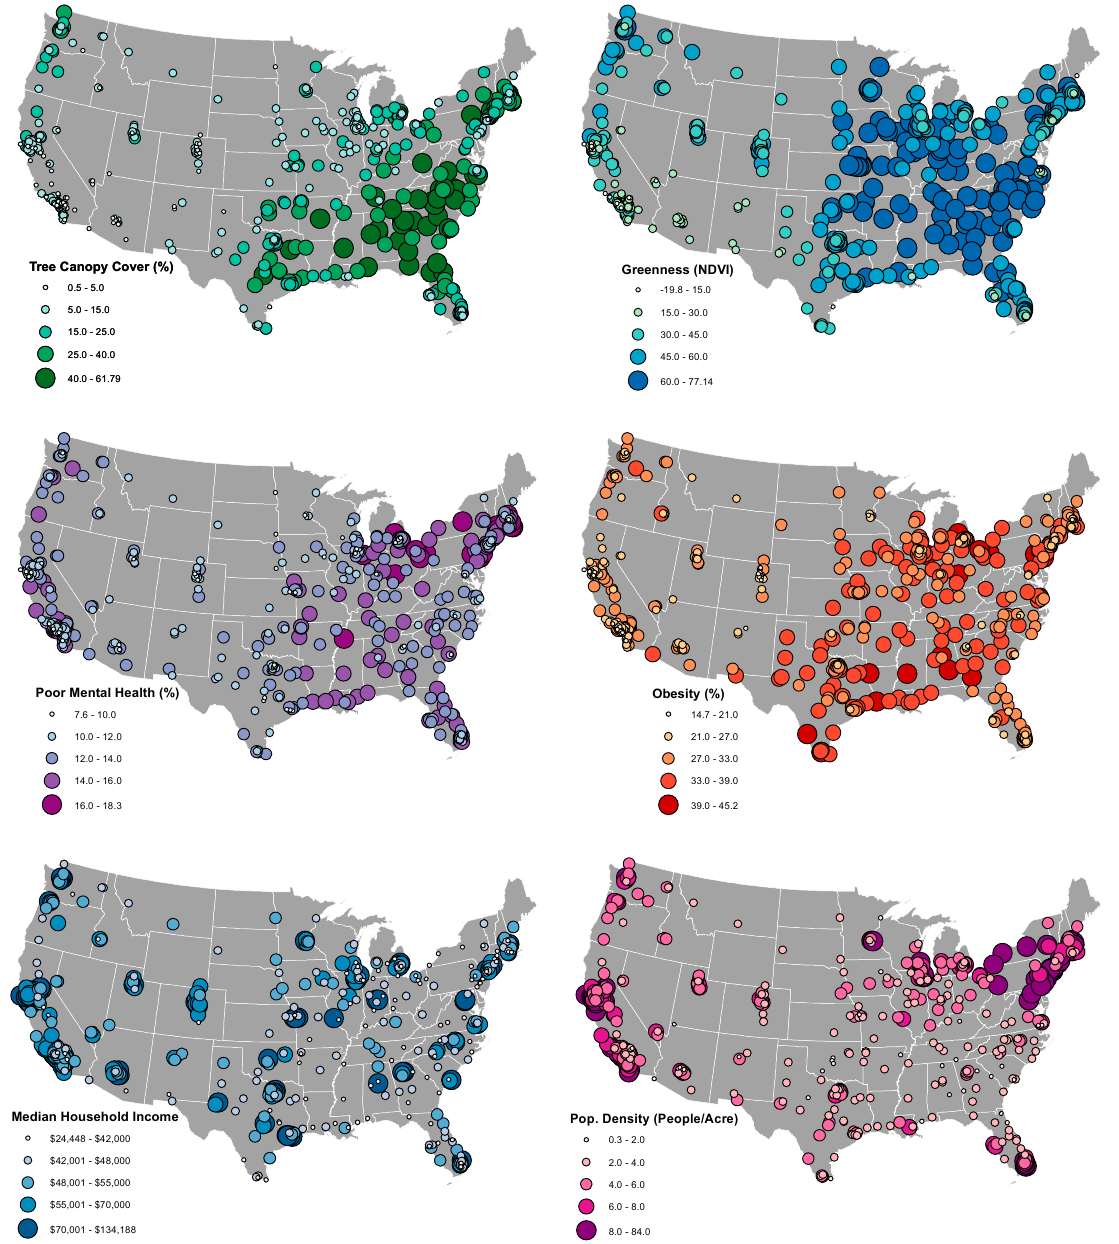
Figure 1. Variation in key health, greenspace, and moderating factor levels in cities across the United States.